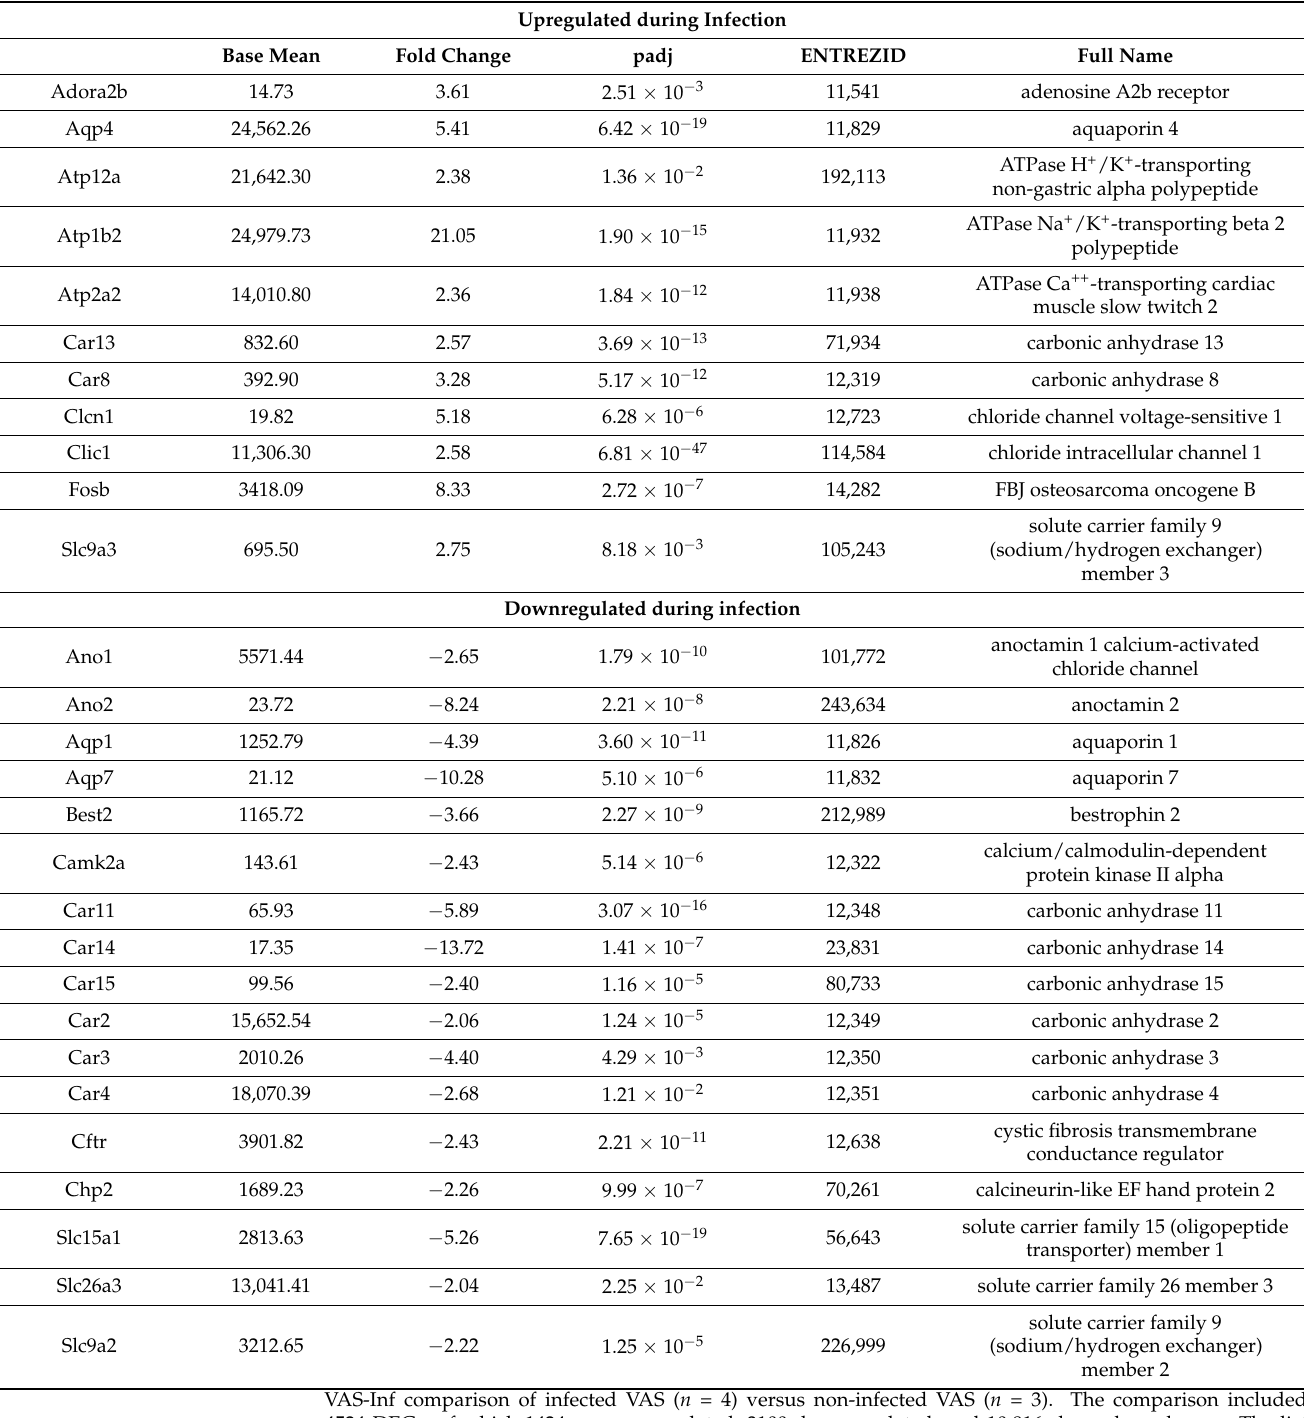
Table 4. Ion transport-related DEGs altered by the C. rodentium infection in the